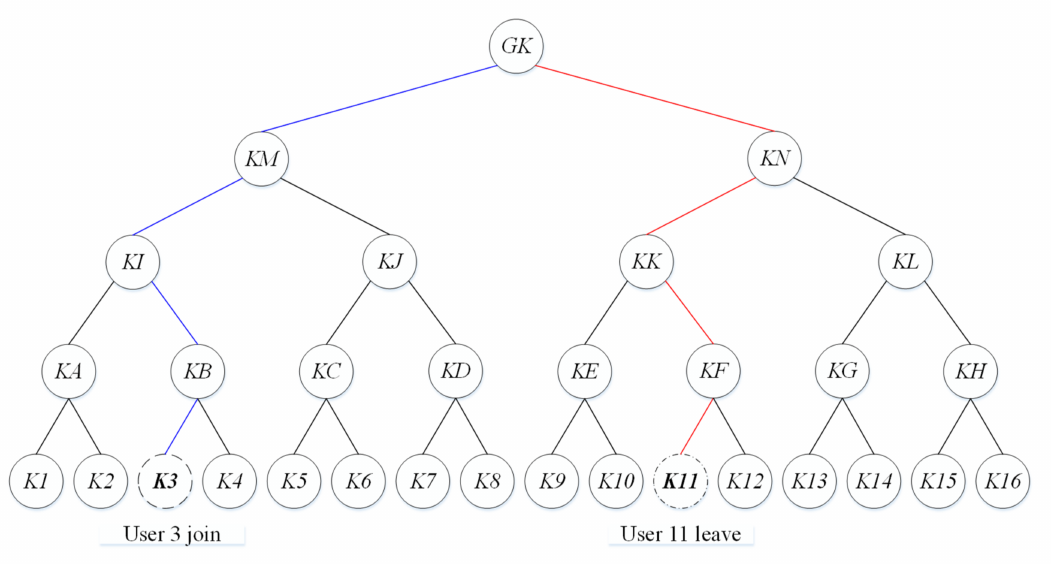
Figure 1. Group key update scheme-based